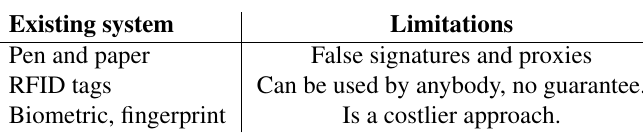
Table 1. Existing systems and their